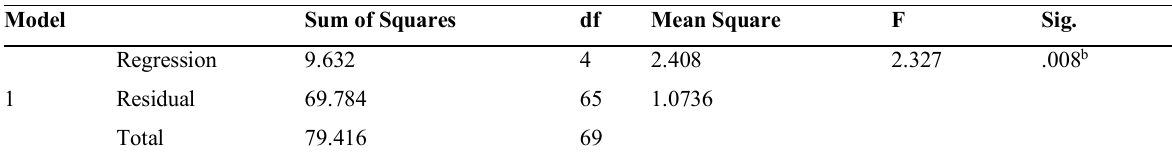
Table 8: ANOVA for Loan Repayment Period Practices